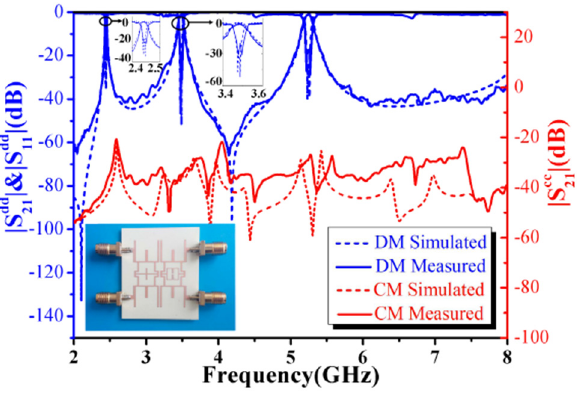
Figure 15. Simulated and measured differential- and common-mode performance of the balanced tri-band BPF with a photograph of the fabricated prototype [74].